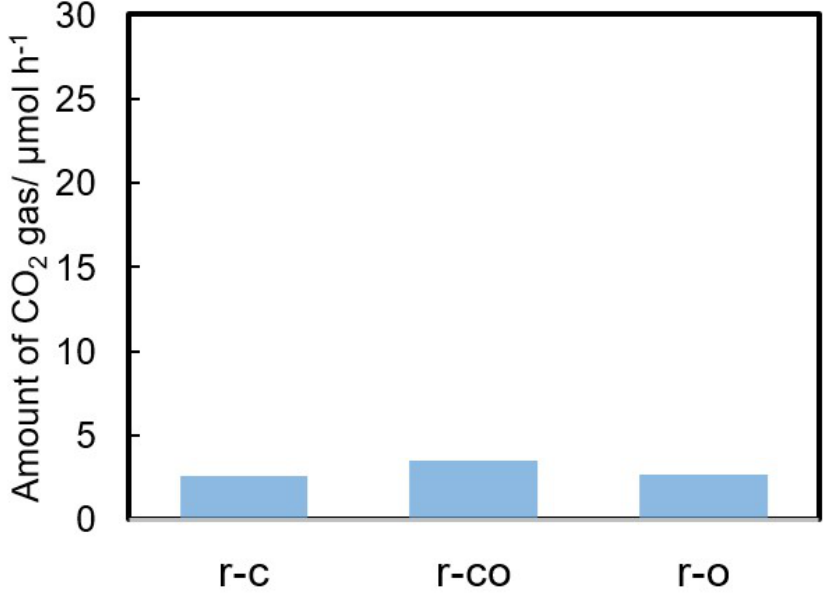
Figure 3. Photocatalytic activity PCFs in a CO 2 system.